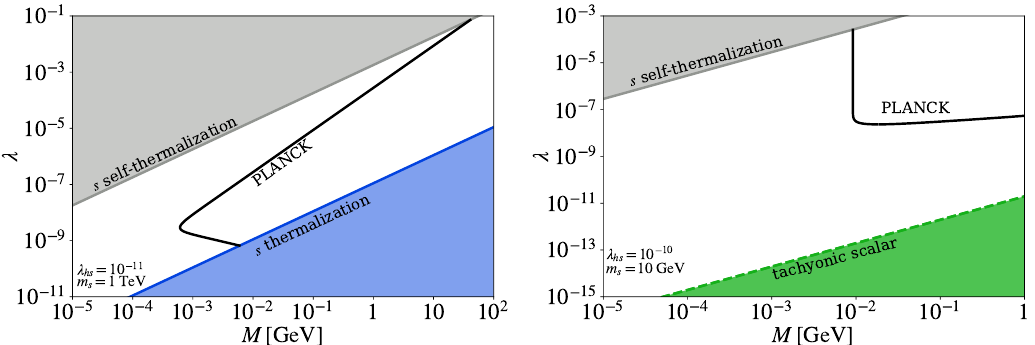
Figure 10 . (cid:21) vs M generating the correct relic DM relic density (\PLANCK") for a non-thermal s . Here s is produced by the freeze-in mechanism via the Higgs thermal bath. In the excluded regions, the freeze-in calculations become unreliable due to e(cid:14)cient hh $ s or ss ! ssss processes leading to